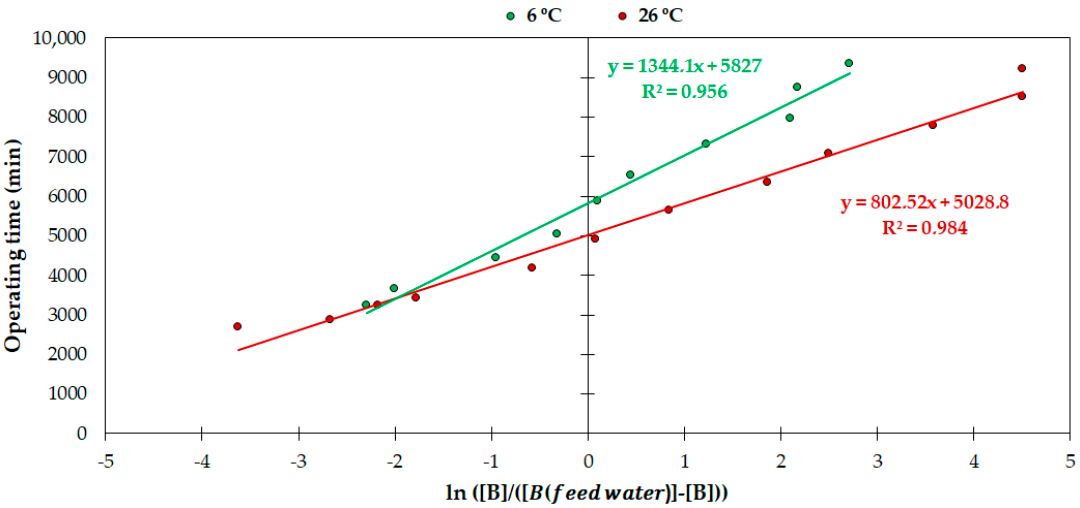
Figure 6. Correlation between time and ln([ B ]/([ B feed water ] − [ B ])) at 6 and 26 °C.